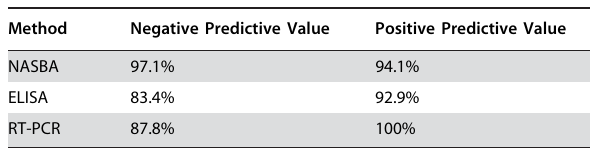
Table 2. Overview on the predictive values of three